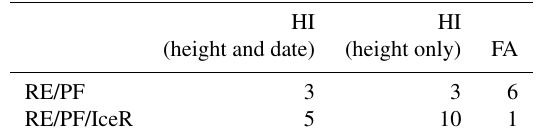
Table 1. Hits (HI) and False Alarms (FA) of simulated ice layers for RE/PF and RE/PF/IceR simulations at WFJ for 17 winter sea- sons from 1999/2000 to 2015/2016. HI (height and date): simulated ice layers that match an observed one formed at less than 20cm of height difference and in the same time interval. HI (height only): simulated ice layers that match an observed one formed at less than 20cm of height difference and less than 1 month away from the ob- served time interval. FA: simulated but not observed ice layers (or more than 1 month away from the simulated formation).